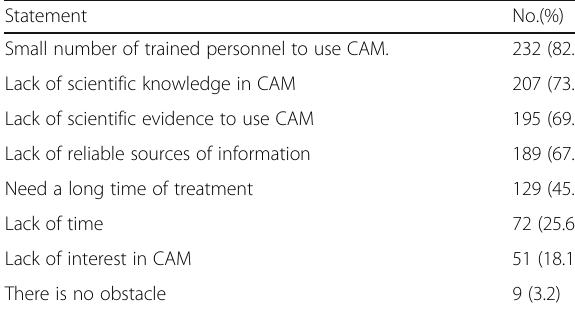
Table 4 The barriers that limit the appropriate use of complementary and alternative